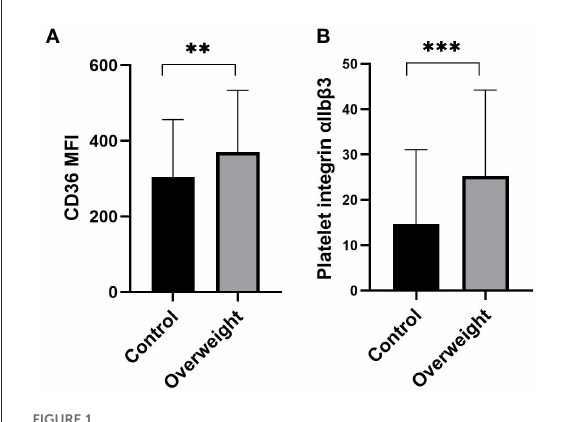
FIGURE1 Expression of platelet CD36 and platelet integrin α IIb β 3. (A) Mean fluorescent intensity (MFI) of platelet CD36 increased significantly in overweight NVAF patients compared with that with normal weight ( P < 0.01). (B) Platelet integrin α IIb β 3 enhanced with increased BMI ( P < 0.01). Data are mean ± SD from at least 3 separate experiments. ** P < 0.01; *** P < 0.001.